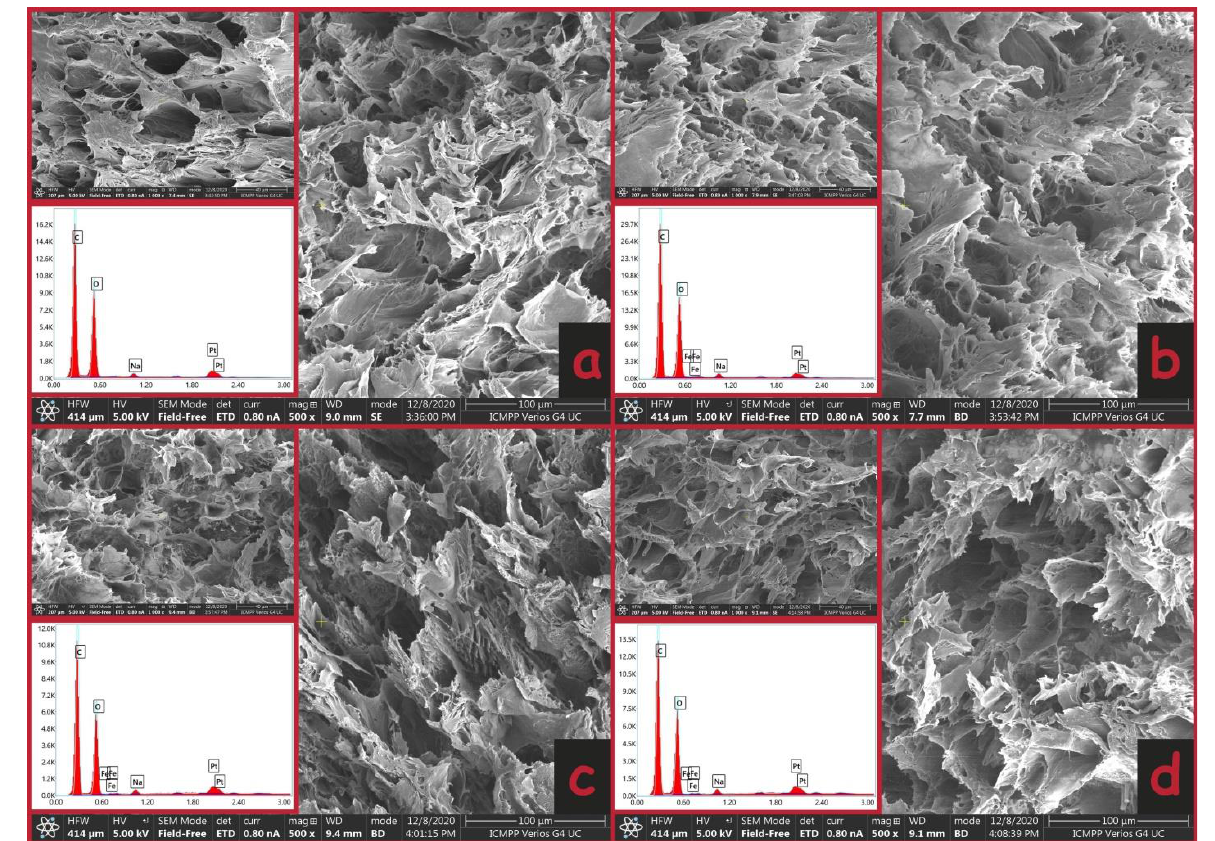
Figure 3. The SEM images and EDX spectra of the prepared hydrogels PVA/CO ( a ), PVA/CO/MFs-1 ( b ), PVA/CO/MFs-10 ( c ) and PVA/CO/MFs-25 ( d ).